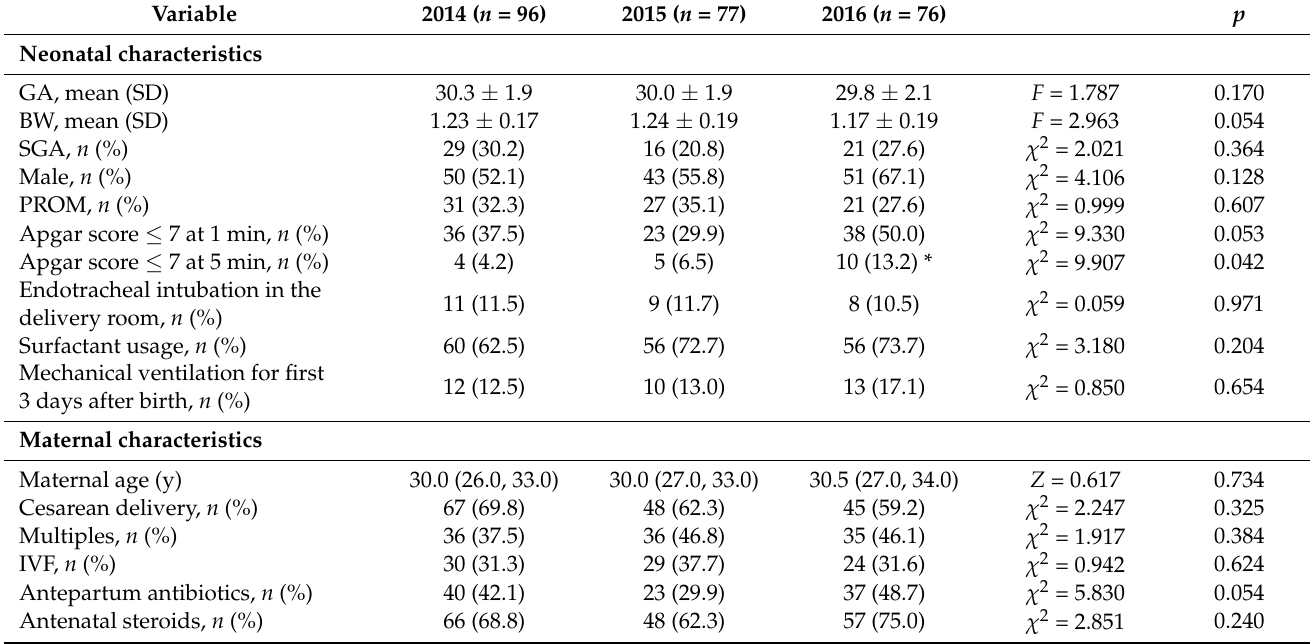
Table 1. Baseline perinatal characteristics of the 3 groups.